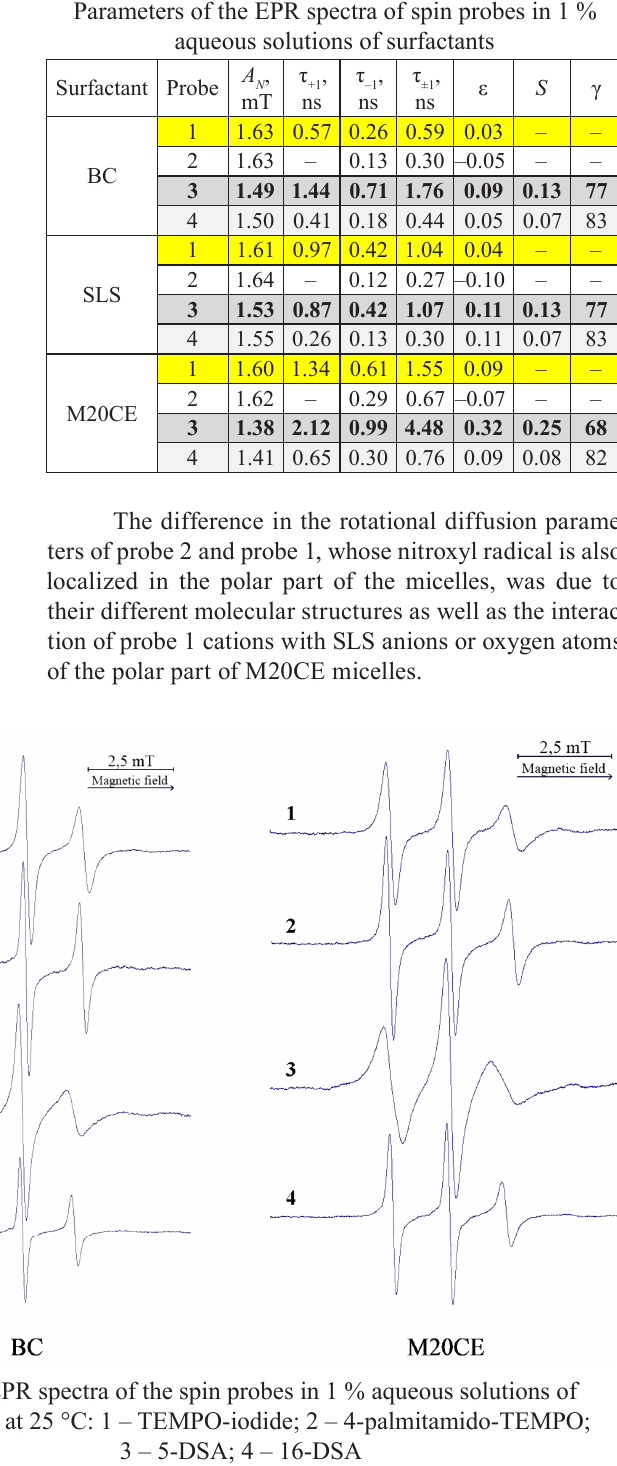
Parameters of the EPR spectra of spin probes in 1 %